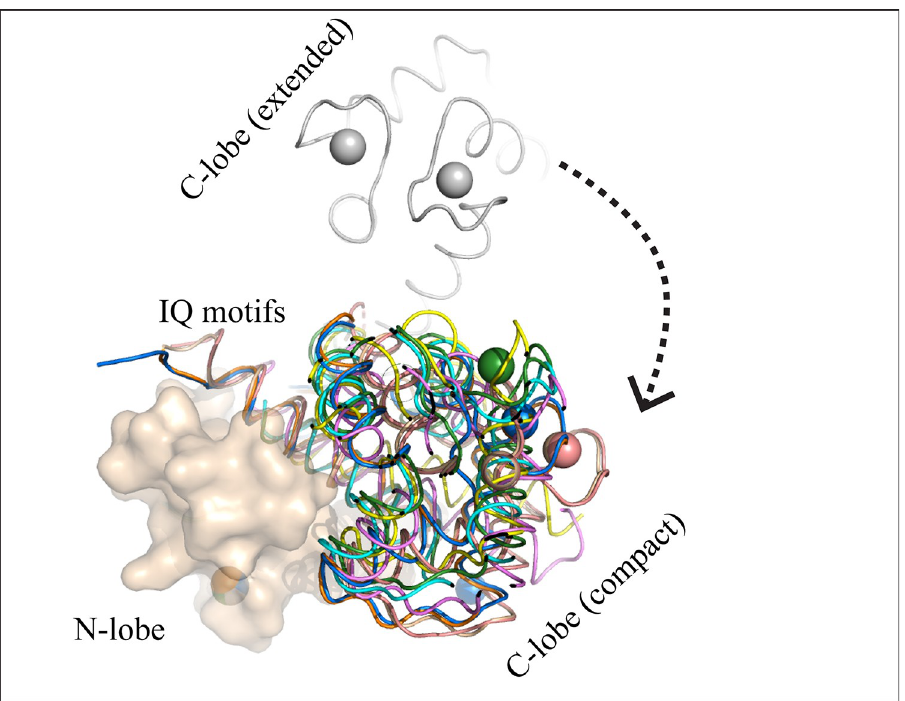
Fig 1. Comparison of the compact and the extended conformations of CaM. The CaM exist in extended form as well as in compact form. In the extended form, the N- and C-lobes are in trans configuration whereas in the compact form, the lobes are in cis configuration. CaM central helix bends to bring the C- and N-lobes close to one another. The C-lobe rotates around the axis to adopt the compact conformation. CaM complexes are coloured as follows: extended Ca 2+ /CaM (1CLL, grey), Ca 2+ /CaM-Cav1.1IQ (2VAY, yellow), Ca 2+ /CaM-Cav1.2IQ (1BE6, violet), Ca 2 + /CaM-Cav2.1IQ (3BXK, cyan), Ca 2+ /CaM-Cav2.1IQ (3DVM, wheat), Ca 2+ /CaM-Cav2.2IQ (3DVE, marine), Ca 2 + /CaM-Cav2.2IQ (3DVJ, orange), Ca 2+ /CaM-Cav2.3IQ (3BXL, forest), and Ca 2+ /CaM-Cav2.3IQ (3DVK, salmon). Ca 2 + are shown in